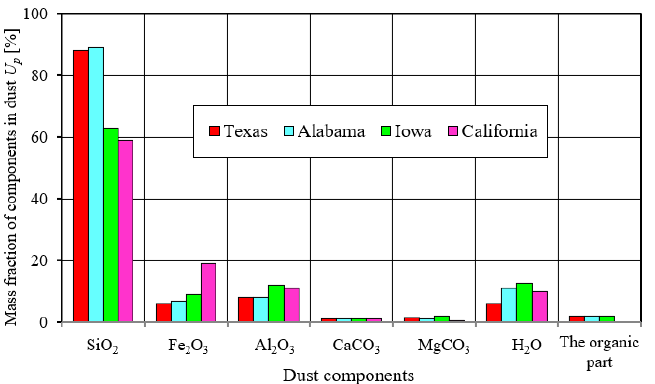
Figure 1. Chemical composition of selected dusts from U.S. substrates. Figure made by author based on data from paper [11].